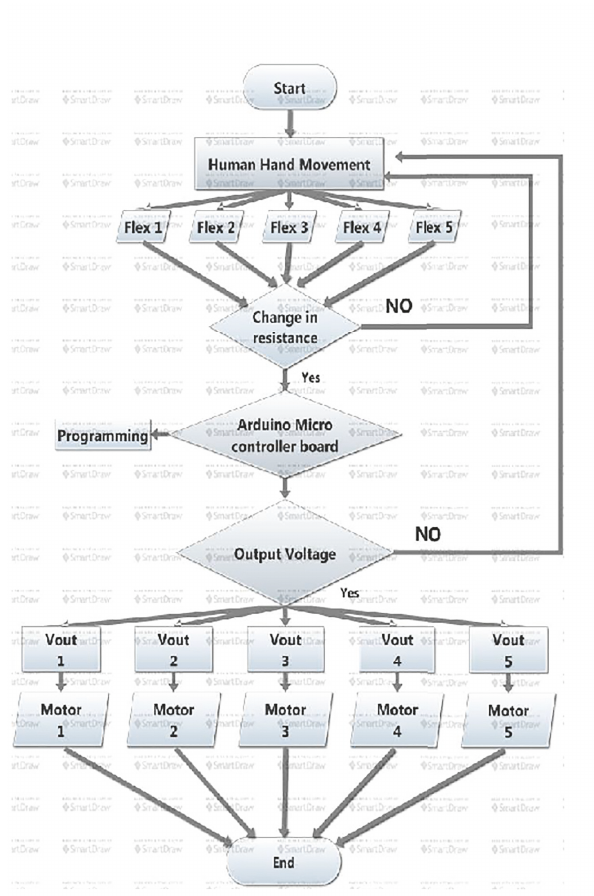
Figure 4: Process flowchart of prosthetic hand.